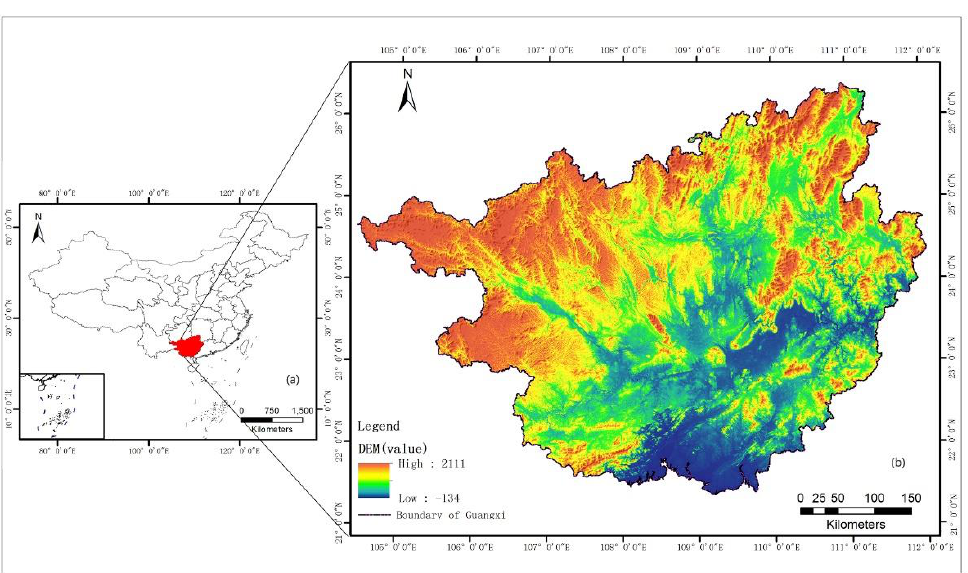
Figure 1. Study area of Guangxi Zhuang Autonomous Region, China. ( a ) China. ( b ) Guangxi Zhuang Autonomous Region.